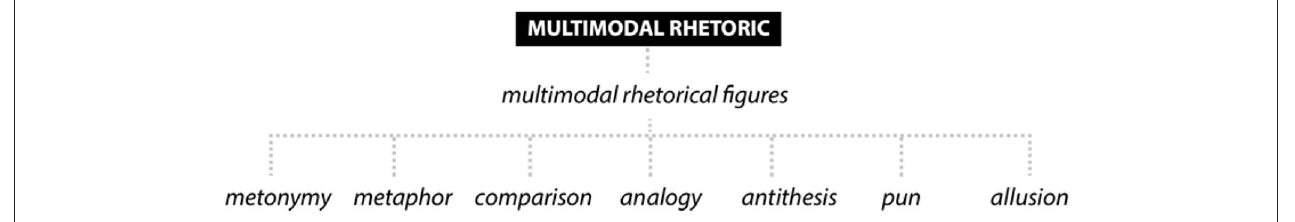
FIGURE 9 | Taxonomic overview of concepts for an analysis of multimodal rhetoric in print ads.